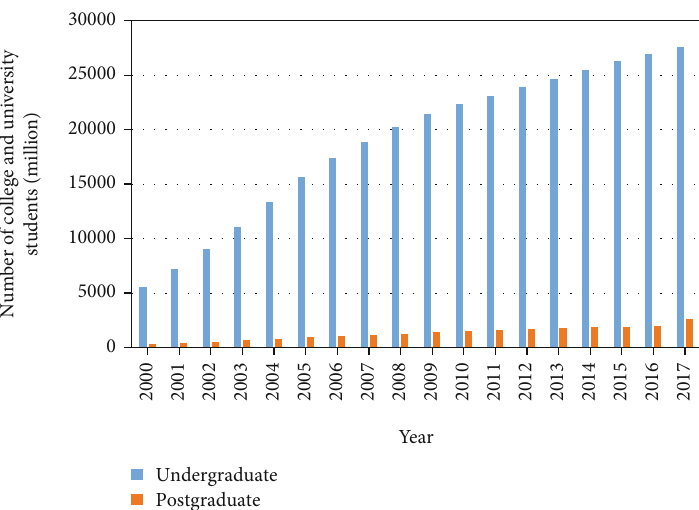
Figure 2: Increase of colleges and universities students.